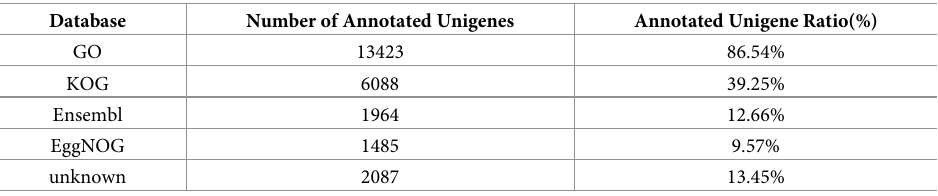
Table 4. Annotation of unigenes BLAST against four different